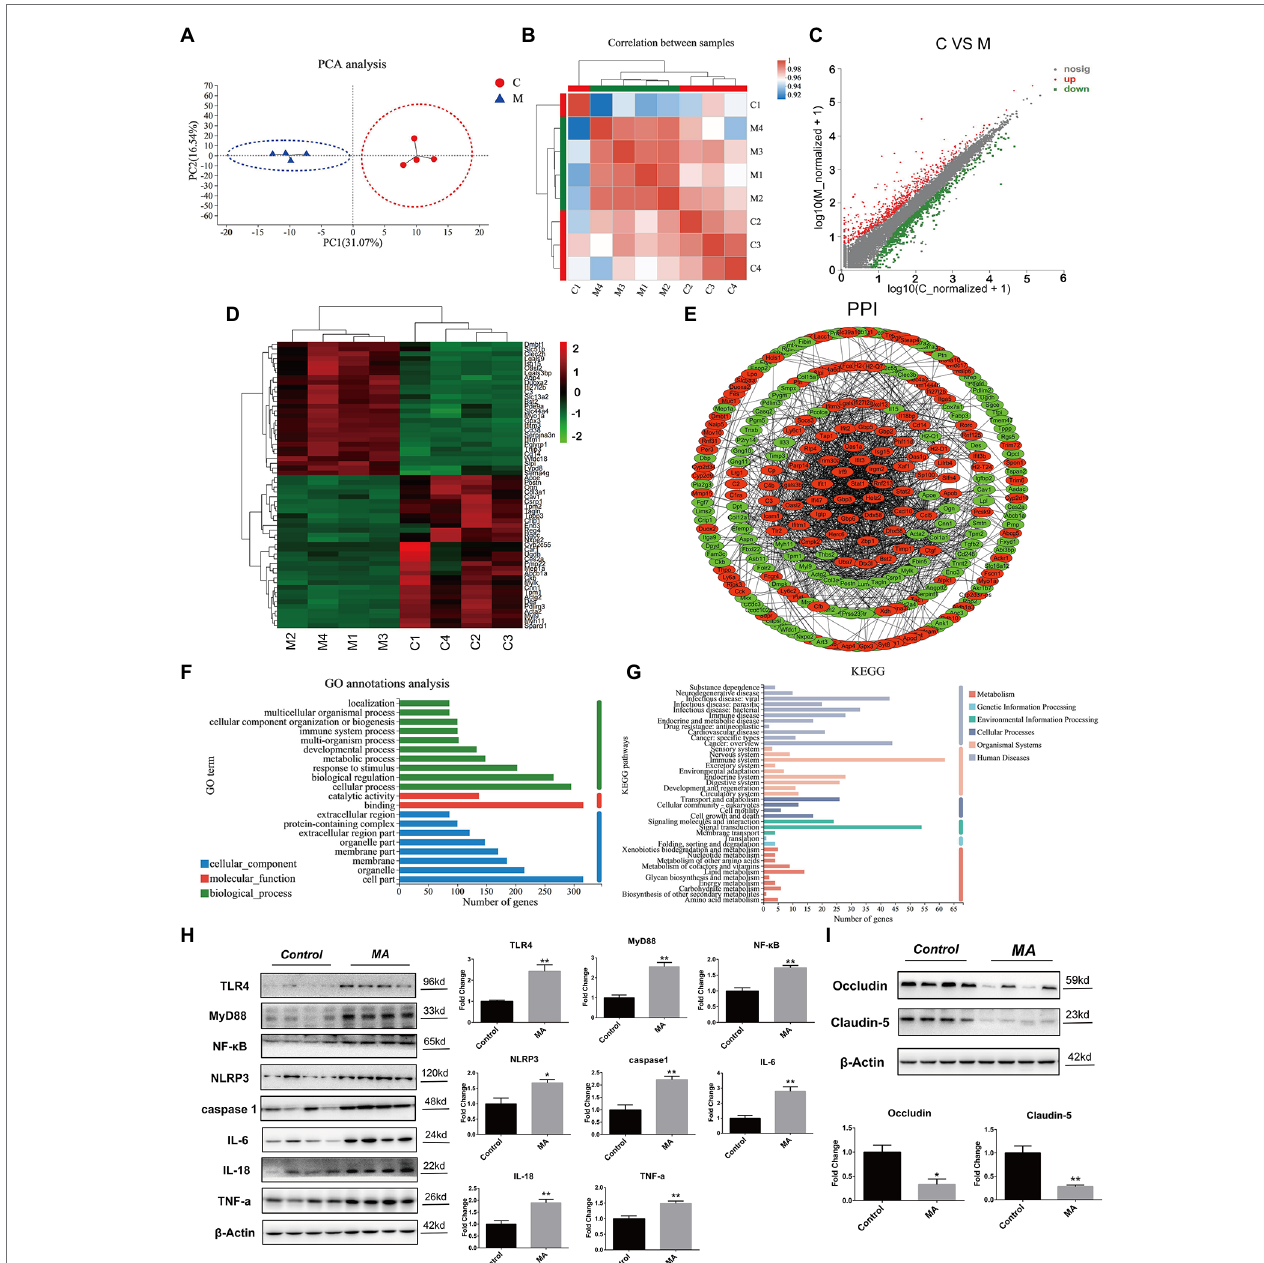
FIGURE 3 | Methamphetamine stimulated inflammation and damaged barrier function in colon. Principal component analysis (PCA) analysis (A) . Samples in the control and MA groups were, respectively, clustered. Correlation analysis (B) . The tree represents correlations among samples, and the color represents the degree of correlation. Identification of differentially expressed genes (DEGs) using the Scatter plot method (C) . Compared to the control group, MA treatment resulted in 414 DEGs (fold change ≥ 2 or ≤ 0.5, value of p < 0.05). Increased DEGs are labeled with red plots, whereas suppressed DEGs are shown in the green plots. Hierarchical clustering of the top 60 DEGs (D) . The tree depicts log10 transformation of average fold changes. Green represents downregulated genes, whereas red denotes upregulated genes. Functional annotations of DEGs. Protein–protein interaction (PPI) analysis of DEGs (E) . MA-induced upregulated DEGs were depicted by red, while downregulated DEGs were displayed by green. Gene Ontology (GO) annotation analysis of DEGs (F) . DEGs were enriched in 10 biological processes (green), eight cellular components (blue), and two molecular functions (red). Kyoto Encyclopedia of Genes and Genomes (KEGG) pathway enrichment analysis of DEGs (G) . DEGs were enriched in 10 metabolisms (red), two Genetic information processing (GIP; light blue), three environmental information processes (green), four cellular processes (CP; dark gray), nine organismal systems (OS; pink), and 11 human diseases (HD; light gray). A western blotting analysis demonstrating colonic expressions of TLR4, MyD88, NF- κ B, NLRP3, caspase 1, TNF- α , IL-6, IL-18, Occludin, and Claudin-5 proteins. In contrast with the control group, MA significantly upregulated the expression levels of TLR4, MyD88, NF- κ B, NLRP3, caspase 1, TNF- α , IL-6, and IL-18 (H) . Of note, MA markedly inhibited Occludin and Claudin-5 protein levels ( I ; 0.01 < * p < 0.05; 0.001 < ** p ≤